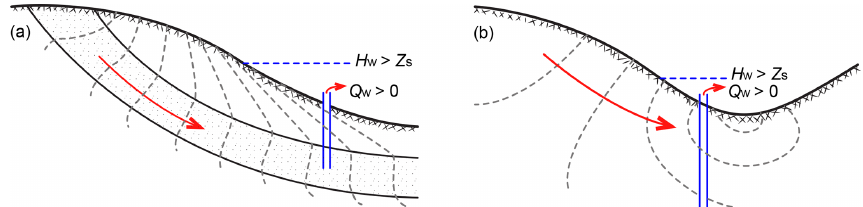
Figure 2. (a) Geologically controlled or confined-flow flowing wells; (b) topographically controlled or unconfined-flow flowing wells (mod- ified from Freeze and Cherry, 1979). It is assumed that the screened intake for the respective well is at its